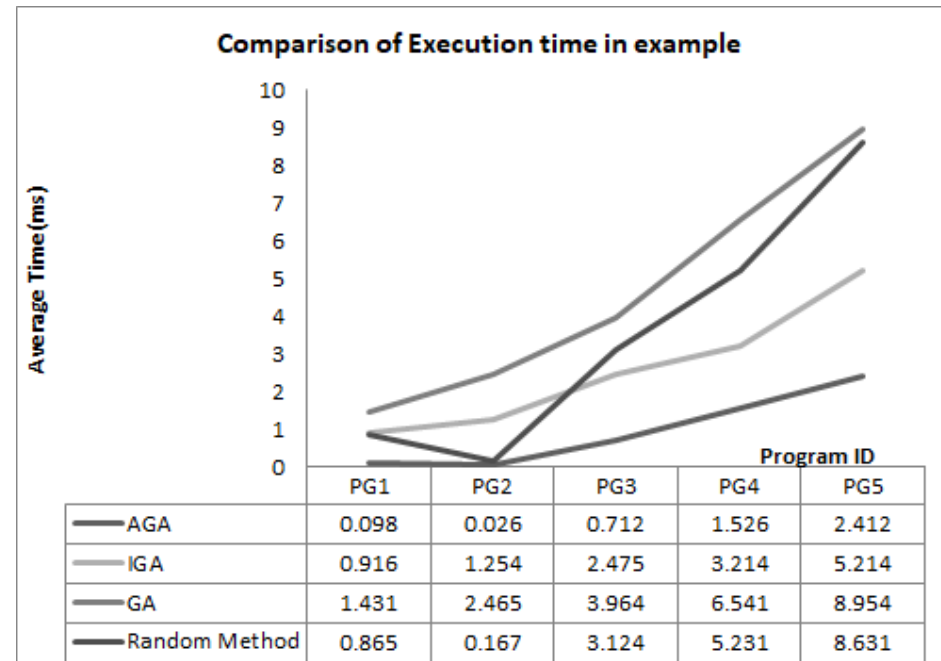
Figure 11. Comparison of execution time in industrial programs in terms of the T(s) on the 5 industrial programs considered, the proposed method doesnot bag the best in all the programs considered. As it is seen that the PG_3 has some deviations. However, it is evident that the average T(s) is minimum as far as when the proposed method is implemented in the industrial programs. It is also evident from Table 6 that the SR is maintained as 100% in case of AGA till the input reaches a large LOC of 8500 whereas, in case of other methods under study, there is a constant decrease in the SR% as the LOC is increased and it reaches 84%, 62%, and 12% as far as the IGA, GA, and random are compared with. The graphical representation is given in Figures 10 and 11,